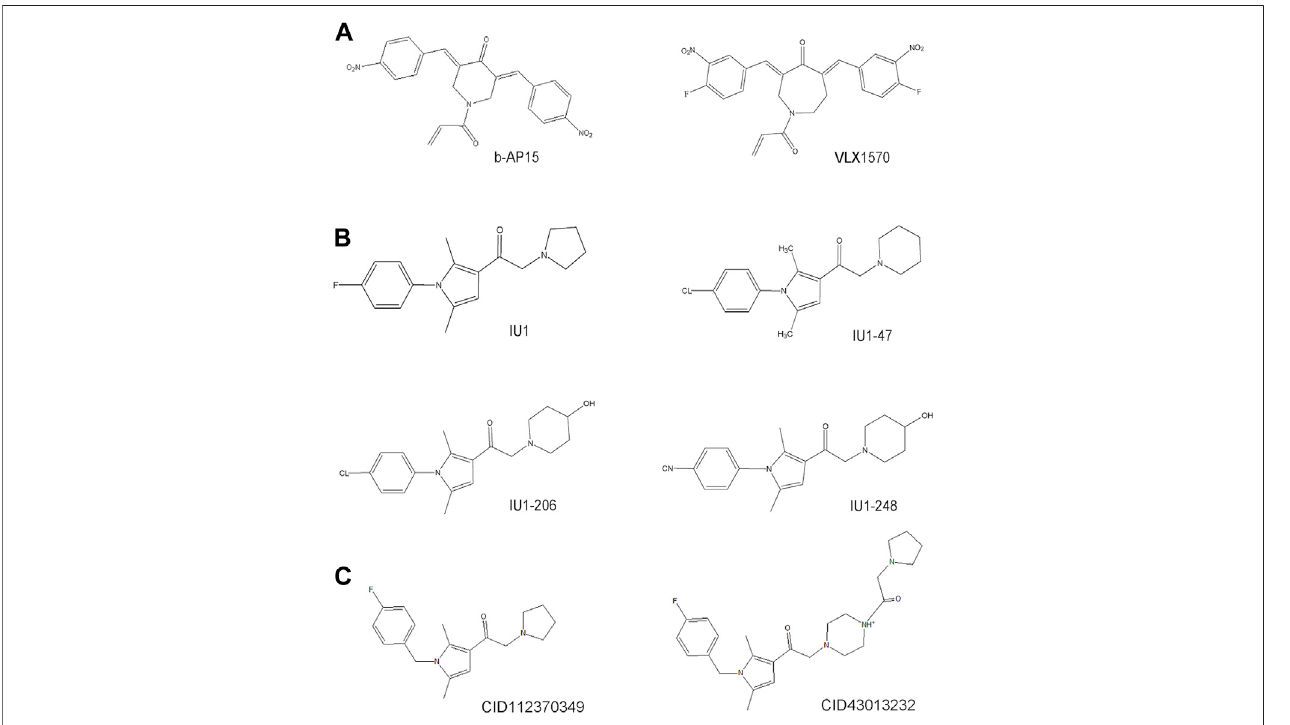
FIGURE 3 | The development process and chemical structure of USP14 inhibitors. (A) A structure-activity relationship (SAR) study was performed based on b-AP15,andidenti fi edananalogVLX1570withimprovedpotencyandenhancedsolubility. (B) Ahighthroughputscreenidenti fi edthe fi rstspeci fi cinhibitorstargetingon USP14, named IU1. Optimization and design of IU1 using the traditional chemistry methods allowed to the identi fi cation of IU1-47 which is 10-fold more potent speci fi c USP14inhibitorIU1.Basedontheco-crystalstructureofUSP14-inhibitorcomplexobtainedIU1-206andIU1-248withanIC50value10-foldmorepotentthanIU1 and is comparable to the IU1-47. (C) Researchers employed the structural bioinformatics methods combining molecular docking identi fi ed novel potential allosteric USP14 inhibitor CID112370349 and CID43013232.